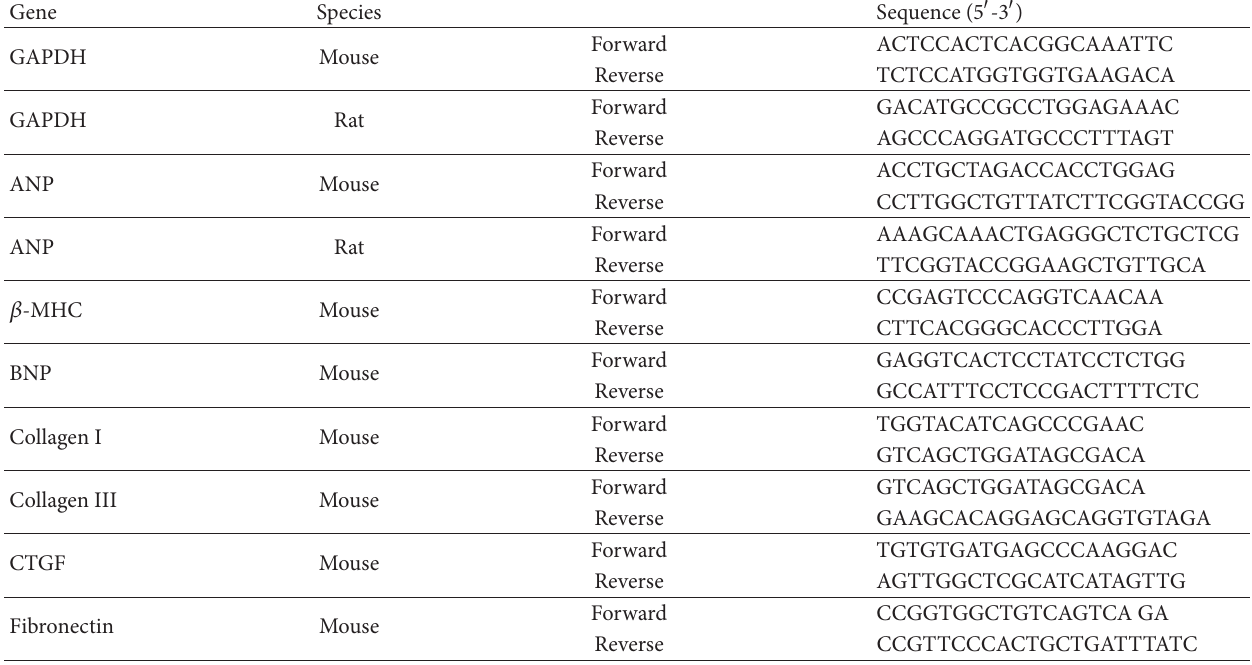
Table 1: Primers used in the